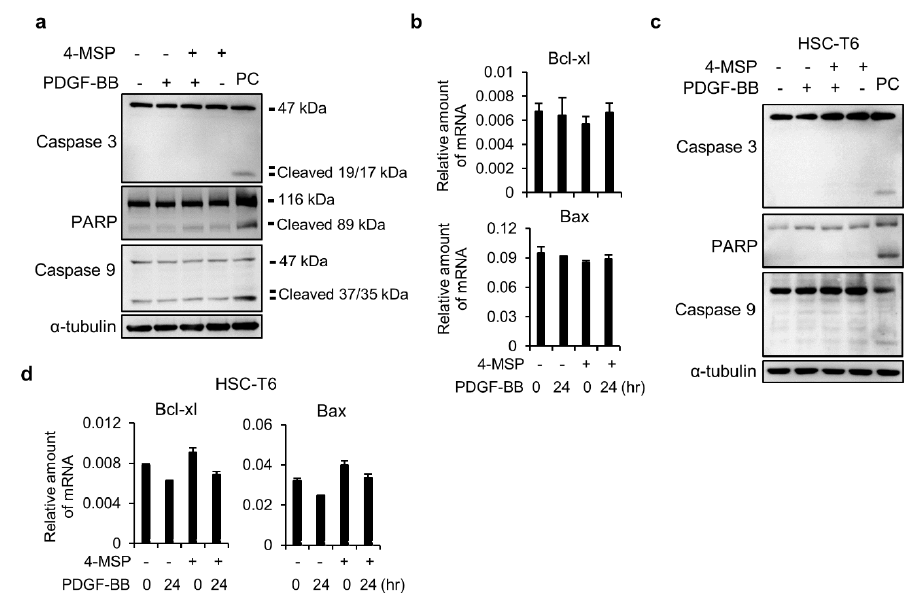
Figure 3. Compound 4-MSP treatment did not induce apoptosis in HSCs. Treatment of LX2 and HSC-T6 cells with PDGF-BB (10 ng/mL) and 4-MSP (5 µM) for 24 h. ( a , c ) Protein levels of Caspase-9, PARP cleavage, and α -tubulin were analyzed by western blotting. PC: positive control. ( b , d ) mRNA levels of Bcl-xl and Bax, relative to that of GAPDH, were measured by real-time RT-PCR. Data shown are at least three independent experiments with similar